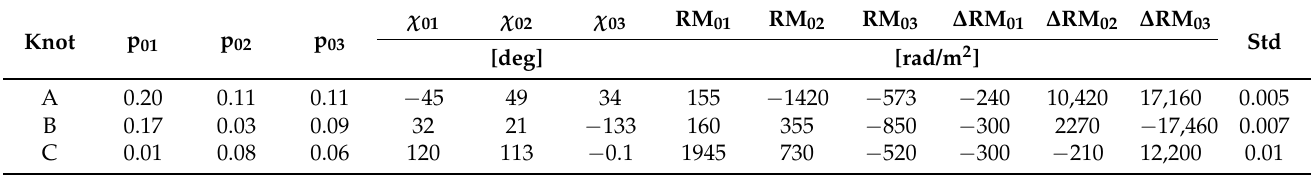
Figure 6. Depolarization modelling of the knots A, B and C. Polarized Stokes parameters q and u of the three knots have been fitted using three internal Faraday screens. Top panels: the magenta points are the Stokes q , the green points are the Stokes u and the black points are the fractional polarization p . Bottom panels: the black points are the polarized angle χ [deg]. Gray dot-dashed lines and red straight lines are the resulted model fit. Table 1. Depolarization parameters resulted from the model fit. Integration has been performed over the